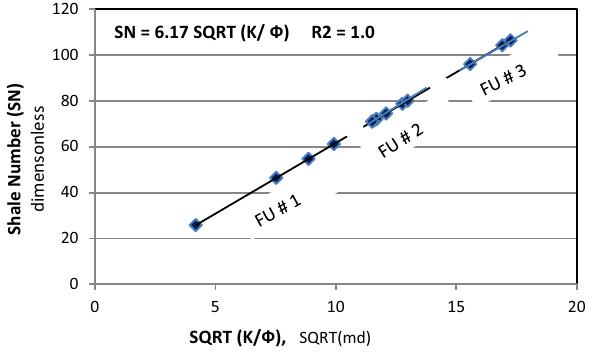
Fig. 8 Cartesian plot of shale number (SN) versus reservoir